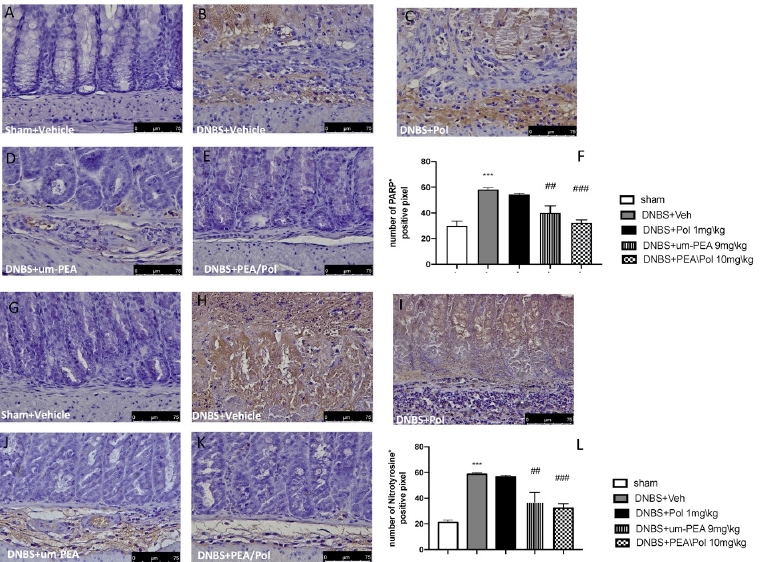
Figure 4. The effects of PEA/Pol on PARP and nitrotyrosine expression after DNBS injection. Immunohistochemistry for PARP was evaluated in sham ( A ), DNBS+Veh ( B ), DNBS+Pol ( C ), DNBS+um-PEA ( D ), and DNBS+PEA/Pol ( E ). The re- sults are expressed as % of positive pixels ( F ). Images are figurative of at least three independent experiments. Immuno- histochemistry for nitrotyrosine was evaluated in sham ( G ), DNBS+Veh ( H ), DNBS+Pol ( I ), DNBS+um-PEA ( J ), and DNBS+PEA/Pol ( K ). The results are expressed as % of positive pixels ( L ). Images are figurative of at least three inde- pendent experiments. Values = means ± SEM of six animals in each group; *** p < 0.001 vs. sham; ## p < 0.01 vs. DNBS, ### p < 0.001 vs. DNBS.